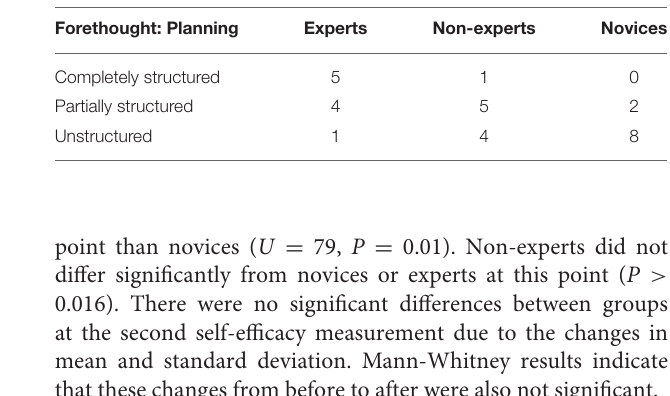
TABLE 2 | The means and standard deviations for the five measures of self-motivation.